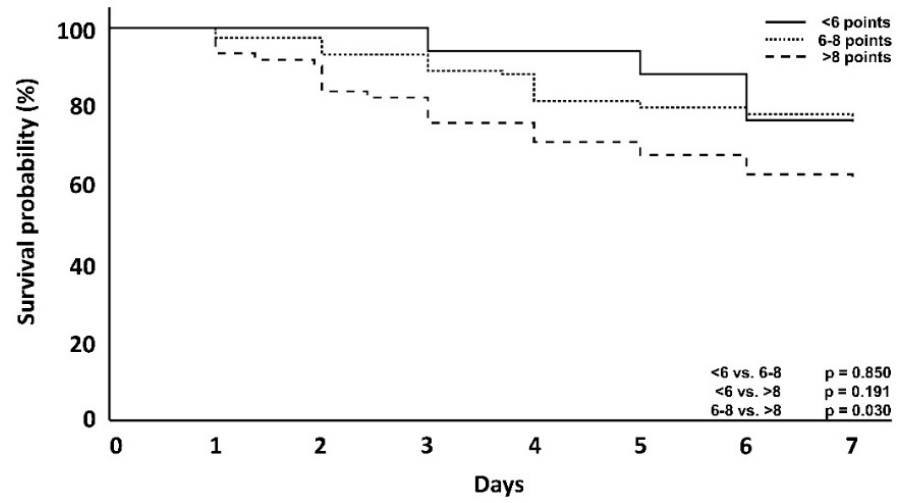
Figure 5. Kaplan–Meyer survival analysis at day 7 of CytoSorb treated patients. The p -value is via log-rank test. * = Statistically significant using Bonferroni-adjusted alpha critical value = 0.017 (no such cases).